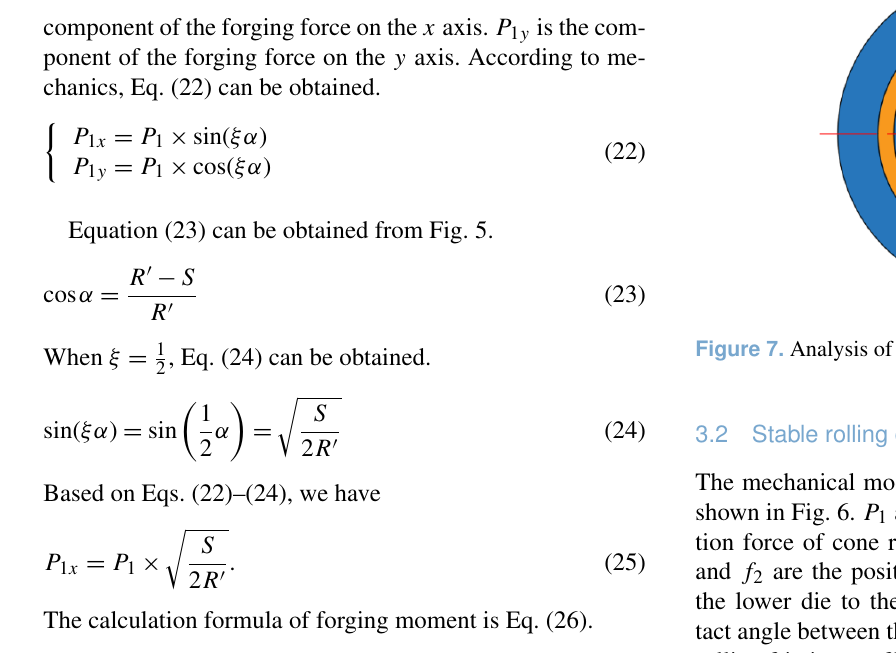
Figure 5. Schematic diagram of the decomposition of the forging force.